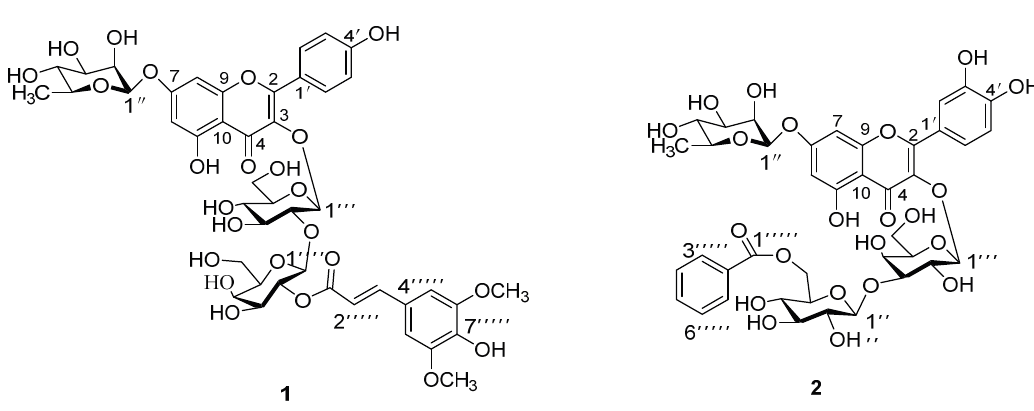
Figure 1. Chemical structures of 1 and 2